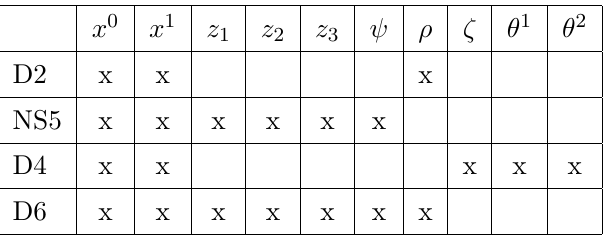
-BPS brane intersection associated to the solutions in [21]. ( x 0 , x 1 ) are the directions Table 5 . 1 8 where the 2d dual CFT lives. ( z ) span the T 4 , on which the NS5 and D6 branes are 1 , z 2 , z 3 , ψ wrapped. The coordinates ( ζ, θ 1 , θ ) are the transverse directions realising the SO(3)-symmetry associated with the isometries of the S 2 .